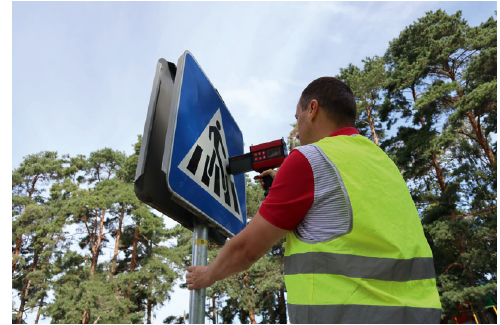
Figure 3. Measuring the road sign